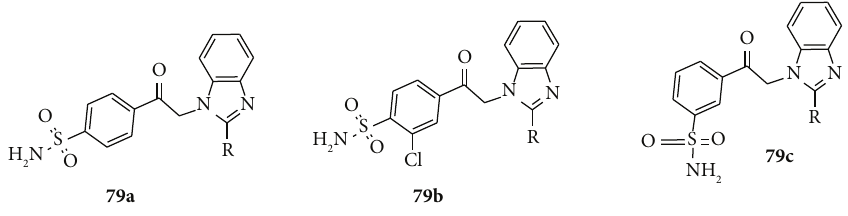
Figure 9: Chemical structures of carbonic anhydrases inhibitors active benzimidazole-sulfonyl derivatives.